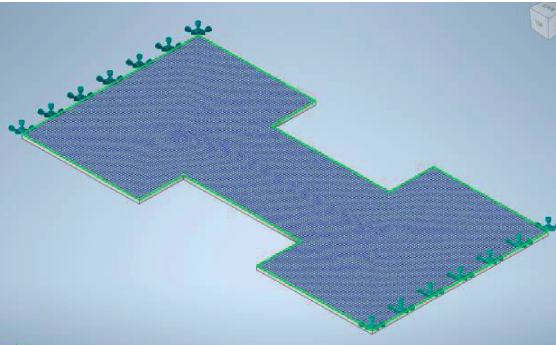
Figure 15: Numerical simulation: mesh and clamped edges. Table 16: FEM simulation: mode shapes and natural frequencies (Case